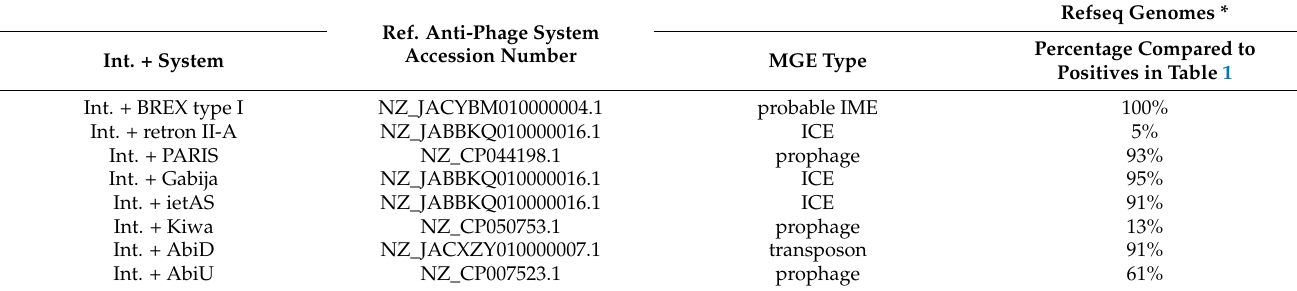
Table 2. Association between reference defense systems and their integrases.